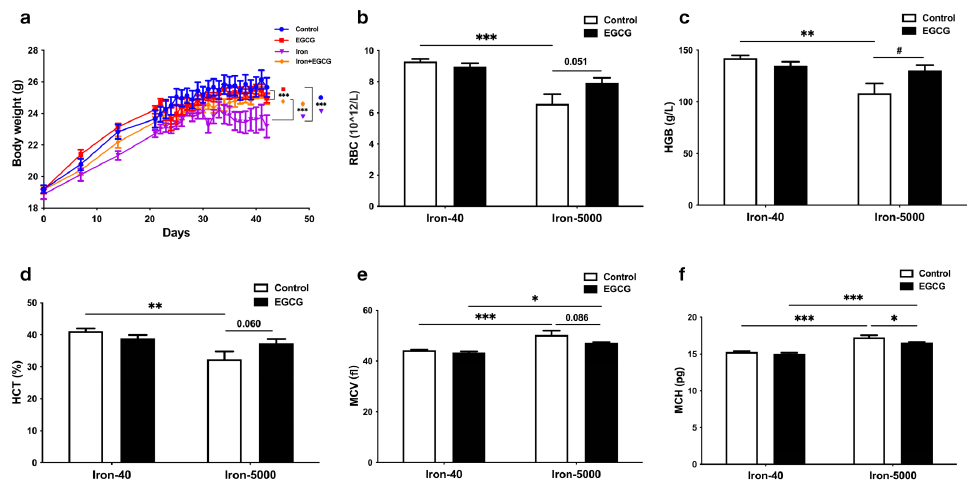
Figure 2. EGCG addition restores impaired growth in mice caused by iron overload. Normal-iron diet (Iron-40) and high-iron diet (Iron-5000) mice were gavaged with EGCG (50 mg/kg body weight per day) or equal volume of PBS separately for 3 weeks, and then serum was collected for analyzing the indexes below. ( a ) The body weight of four groups of mice during the experiment was measured. Mouse body weight was measured weekly for the first three weeks and daily after starting gavage ( n = 10). ( b – f ) The blood RBC ( b ), HGB ( c ), HCT ( d ), MCV ( e ), and MCH ( f ) levels of all the experimental groups were tested after anesthesia and euthanasia of the mice. Data are expressed as means ± SEM. The results of the two-way ANOVA and t -test analysis are, respectively, denoted by an asterisk (*) and a hashtag (#), and the remaining results are represented by p -values. p < 0.05 (*), p < 0.01 (**), p < 0.001(***), p < 0.05 (#).